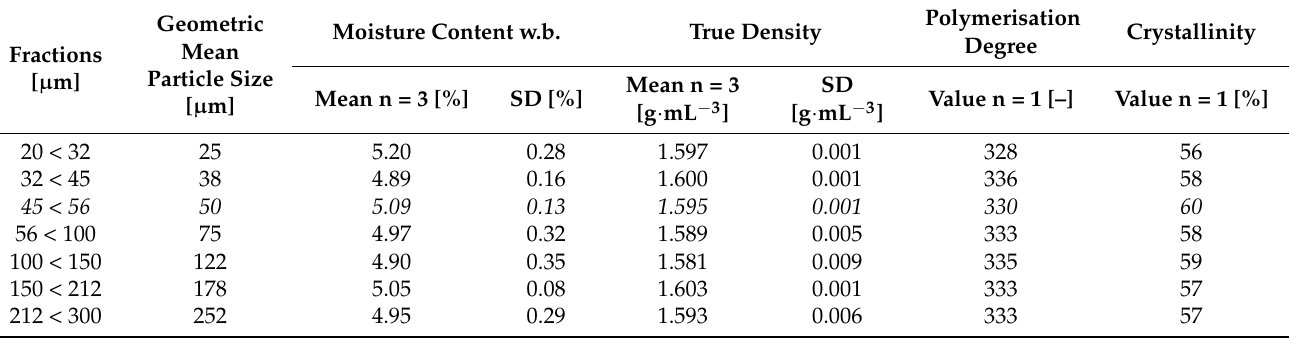
Table 1. Basic material